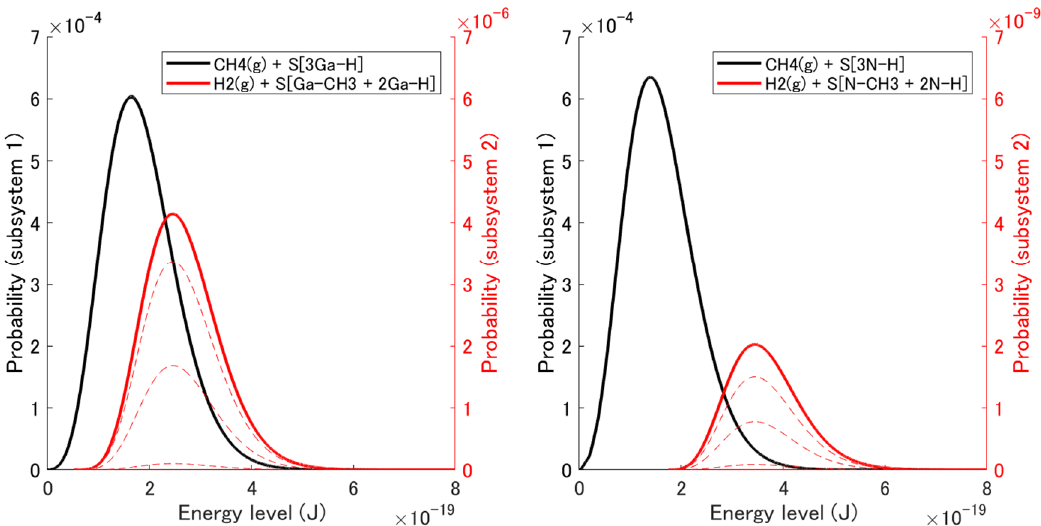
Figure 4. Probability distribution among the energy eigenlevels for the adsorption reaction in (0001) and (000 − 1). The bold solid lines correspond to the stable equilibrium state, while the narrow dashed lines correspond to intermediate states during the relaxation.